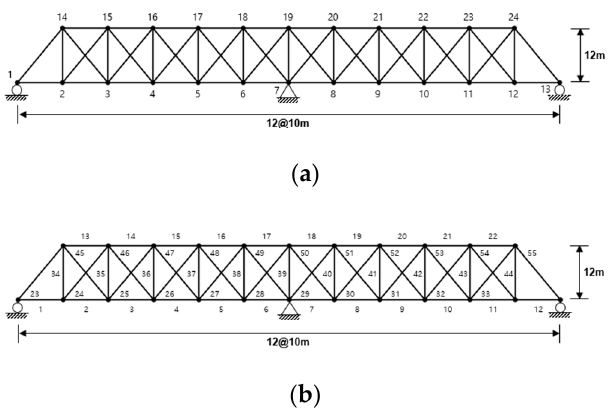
Figure 3. FEM model for validation (beam): ( a ) node number, ( b ) element number.